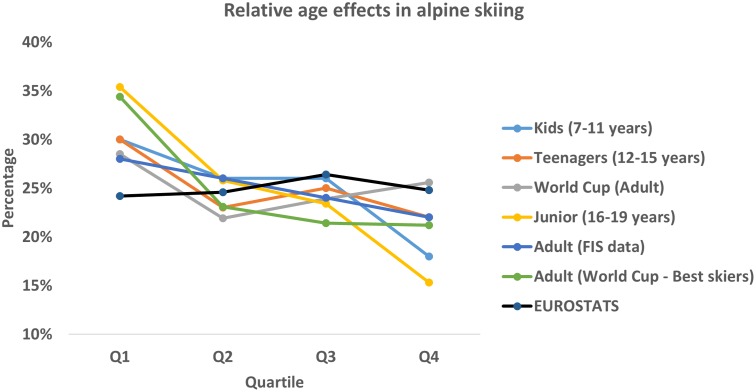
Relative age effects in alpine skiing across ages and samples: Kids/Teenagers from Müller et al. (2015); Adult (World Cup)/Junior from Müller et al. (2012); adult (FIS data) from Baker et al. (2014); adult (World Cup – best skiers) from Bjerke et al. (2016); EUROSTATS – distributions of 53 million live births in the European Union the past decade.